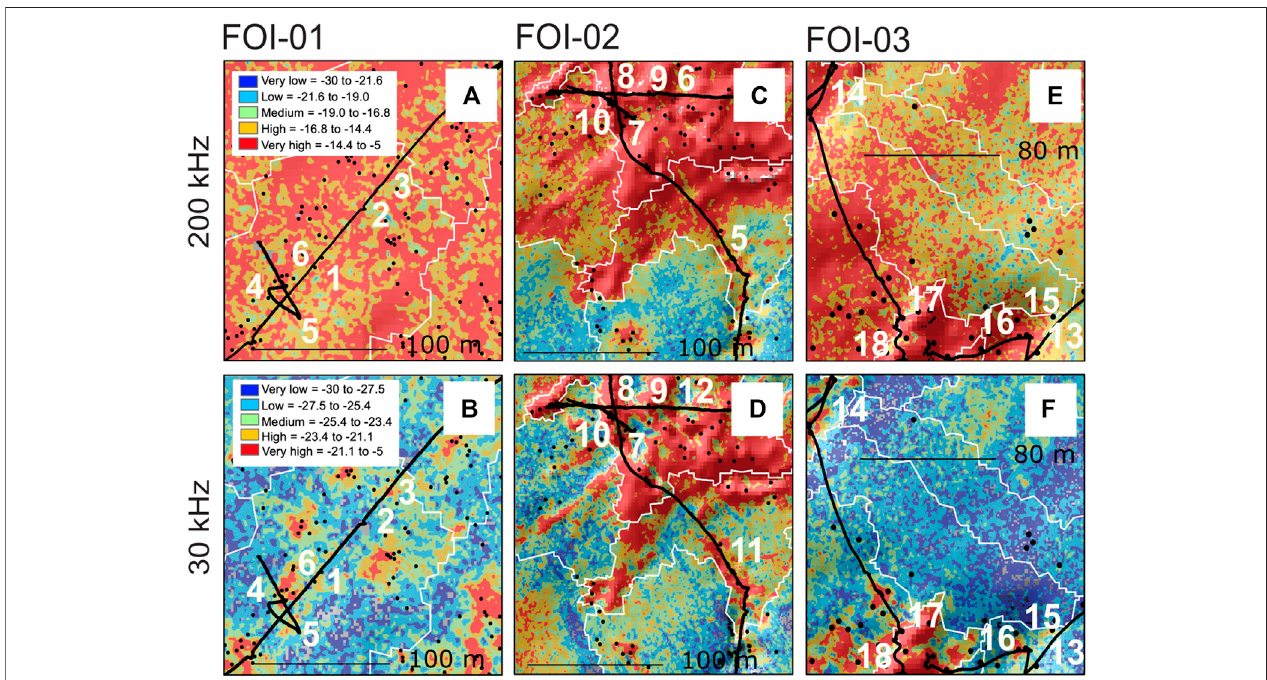
FIGURE8| Towed camera transects (black lines) for three features of interest (FOI; see Figure 1B for locations) mapped over 200 kHz mosaic (A,C,E) and 30 kHz mosaic (B,D,E) show a variety of substrates both with and without active fl uid expulsion. Black dots - seep base locations; mosaic resolution 2 m; projection NZTM; white lines: segments of best performing models for North (SP46 combined) and South (SP75 combined). Numbers correspond to still images in Figure 9 .